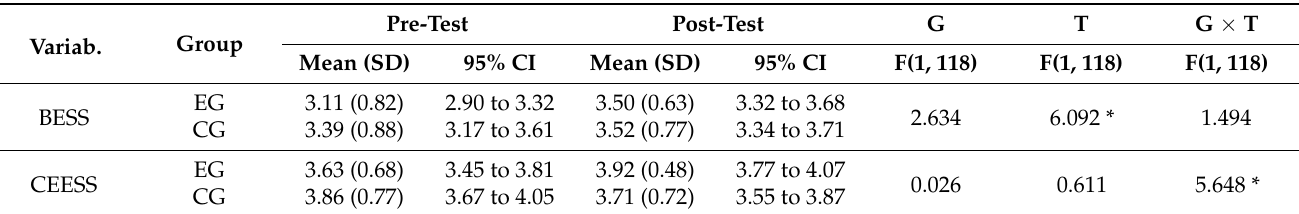
Table 4. Changes in exercise self-schemata over the